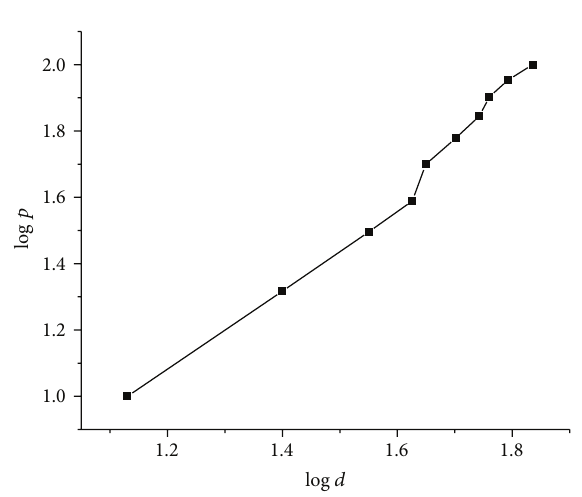
Figure 8: Plot of indentation ( 𝑑 ) versus load ( 𝑝 ).